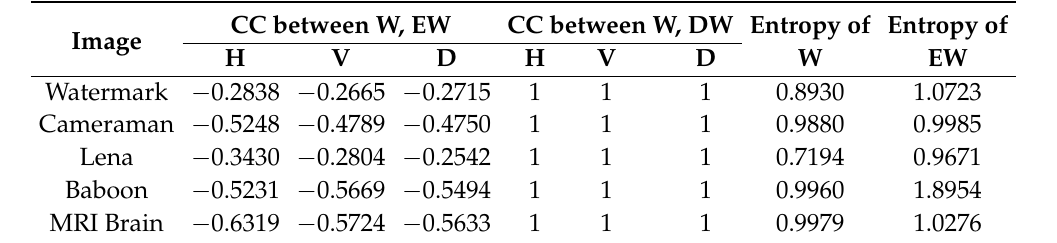
Table 8. CC values between original watermark image (W) and encrypted images (EW). CC values between original image and decrypted images (DW) and entropies of original image and encrypted images (H—horizontal, V—vertical, D—diagonal).